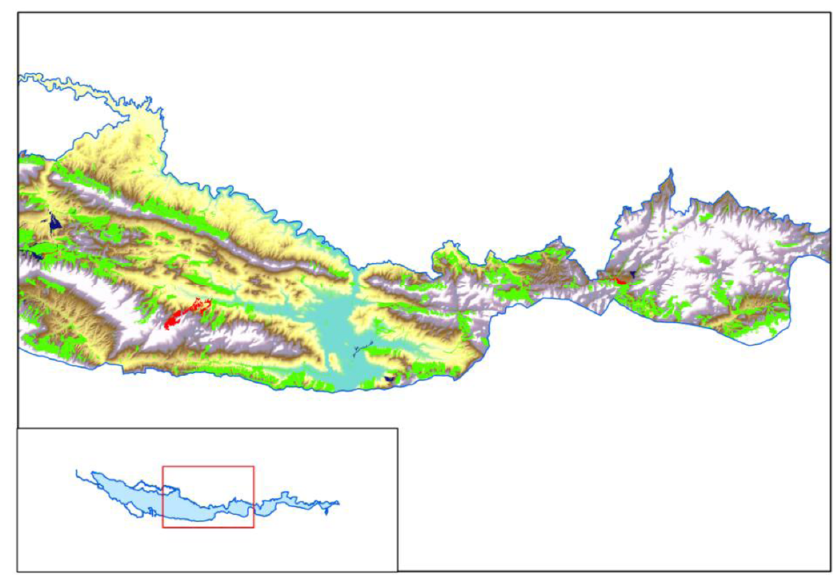
( b ) SCI: Sierra Morena. Mapped associations (habitat). Blue: 9240, 824030. Red: 9240. Green: 9240, 824031 Figure 2. ( a , b ) 9240 Quercus faginea and Quercus canariensis Iberian woods. Longitude 4°18′16″ W, latitude 38°24′24″ N (Fuencaliente). 824030 Quercion broteroi Br.-Bl., P. Silva and Rozeira, 1956 em. Rivas-Martinez, 1975 corr. Ladero 1974. (Sierra Morena, blue polygons). 824031 Pistacio terebinthi- Quercetum broteroi Rivas Goday in Rivas Goday, Borja, Esteve, Galiano, Rigual, and Rivas-Martí- nez 1960. (Sierra Morena, green polygons). xxxxxx Pyro bourgaeanae-Quercetum broteroi Cano, Gar- cía-Fuentes, Torres, Pinto-Gomes, Cano-Ortiz, Montilla, Muñoz, Ruiz, and Rodríguez 2004. xxxxxx Doronico plantaginei-Quercetum canariensis Rivas-Martínez and Cano 2011. The map shows the mar- cescent forests of Portuguese oak, Quercus faginea and Quercus canariensis in three plant associa- tions in sites of community interest.